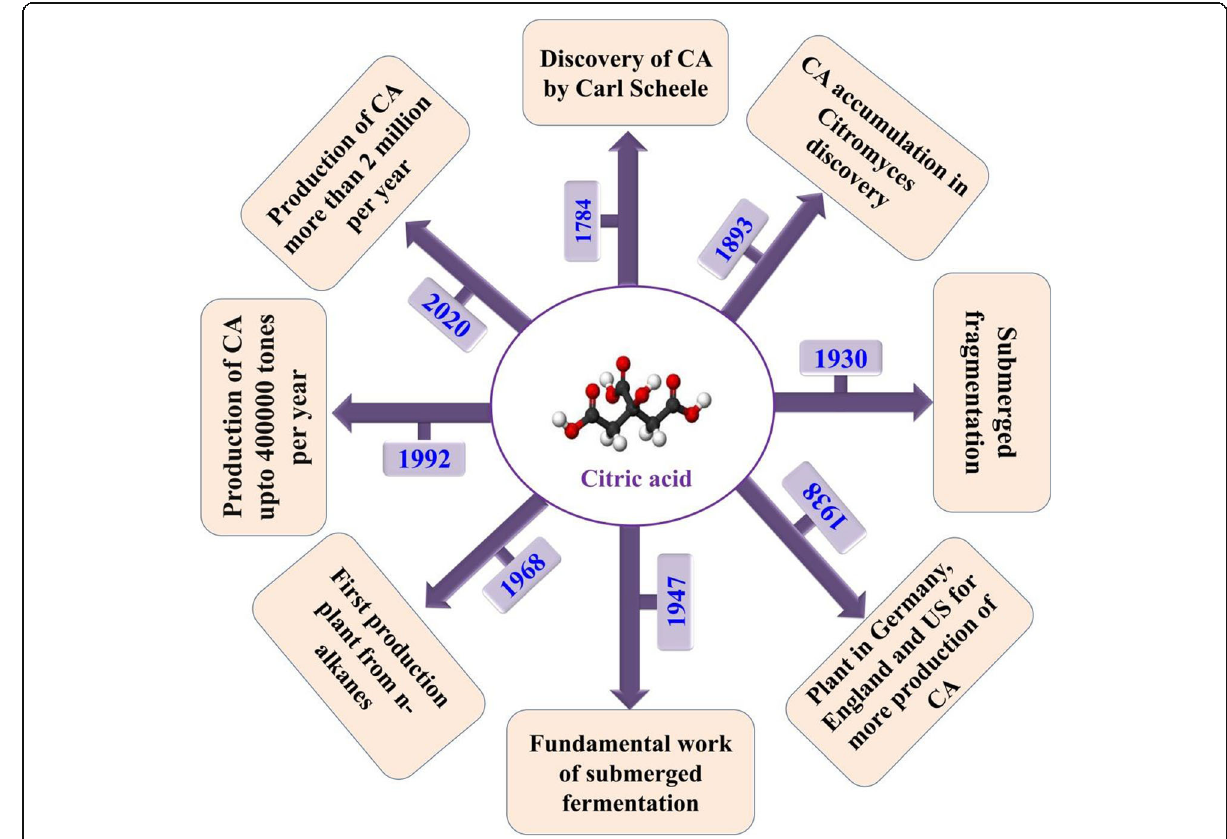
Fig. 2 Diagram of the developmental stages of the discovery and manufacturing of